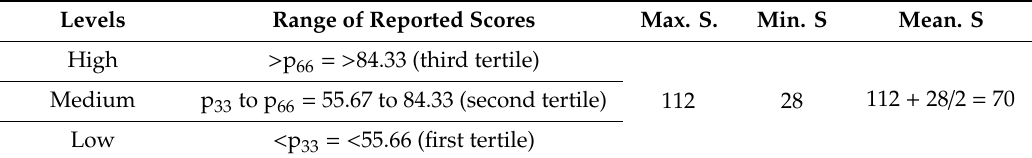
Table 3. The score intervals forming each tertile, and the maximum, minimum and mean scores for each scale. Levels Range of Reported Scores Max. S. Min. S Mean. S High